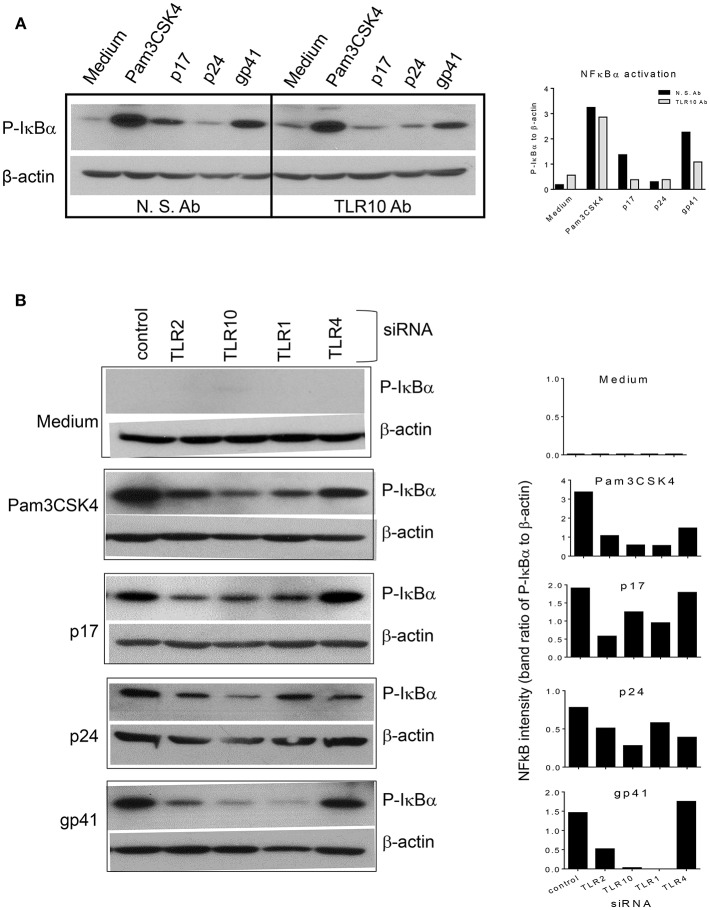
siRNA mediated knockdown or antibody mediated blocking of TLR10 inhibits NF-κBα activation induced by HIV-1 proteins (A) anti-TLR10 antibody decreased gp41 induced P-IκBα by half in MCF-10A cells. (B) TLR10 siRNA ablated the induction of P-IκBα by gp41 in THP-1 cells.